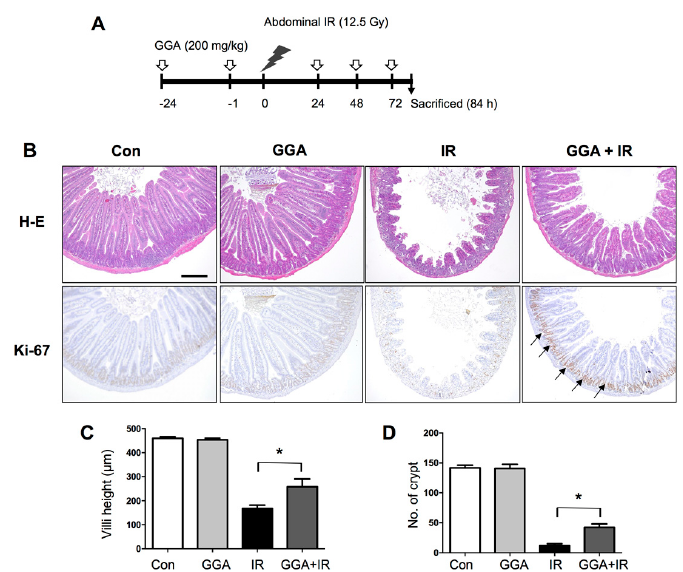
Figure 1. Protective effect of geranylgeranylacetone (GGA), on radiation-induced intestinal injury. ( A ) Diagram of the protocol for GGA administration and abdominal irradiation. Five doses (200 mg/kg) of GGA were orally administered to mice at the indicated time points before and after 12.5 Gy of IR; ( B ) Histopathological evaluation; villi height and number of surviving crypts were measured in the hematoxylin and eosin (H-E)-stained intestinal section. Proliferative intestinal crypt cells were shown by Ki-67 immunohistochemical staining (arrows; brown color); scale bar = 200 µ m. Quantitative analysis of ( C ) the villi height and ( D ) the numbers of crypts. The data are presented as the mean ± SEM; n = 8, * p < 0.05.